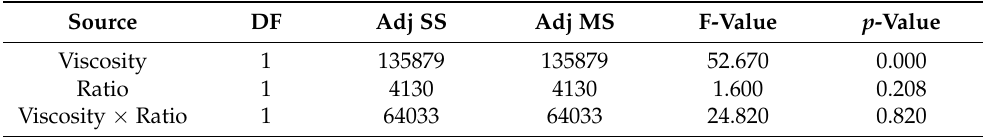
Table 4. ANOVA table for nanopores.